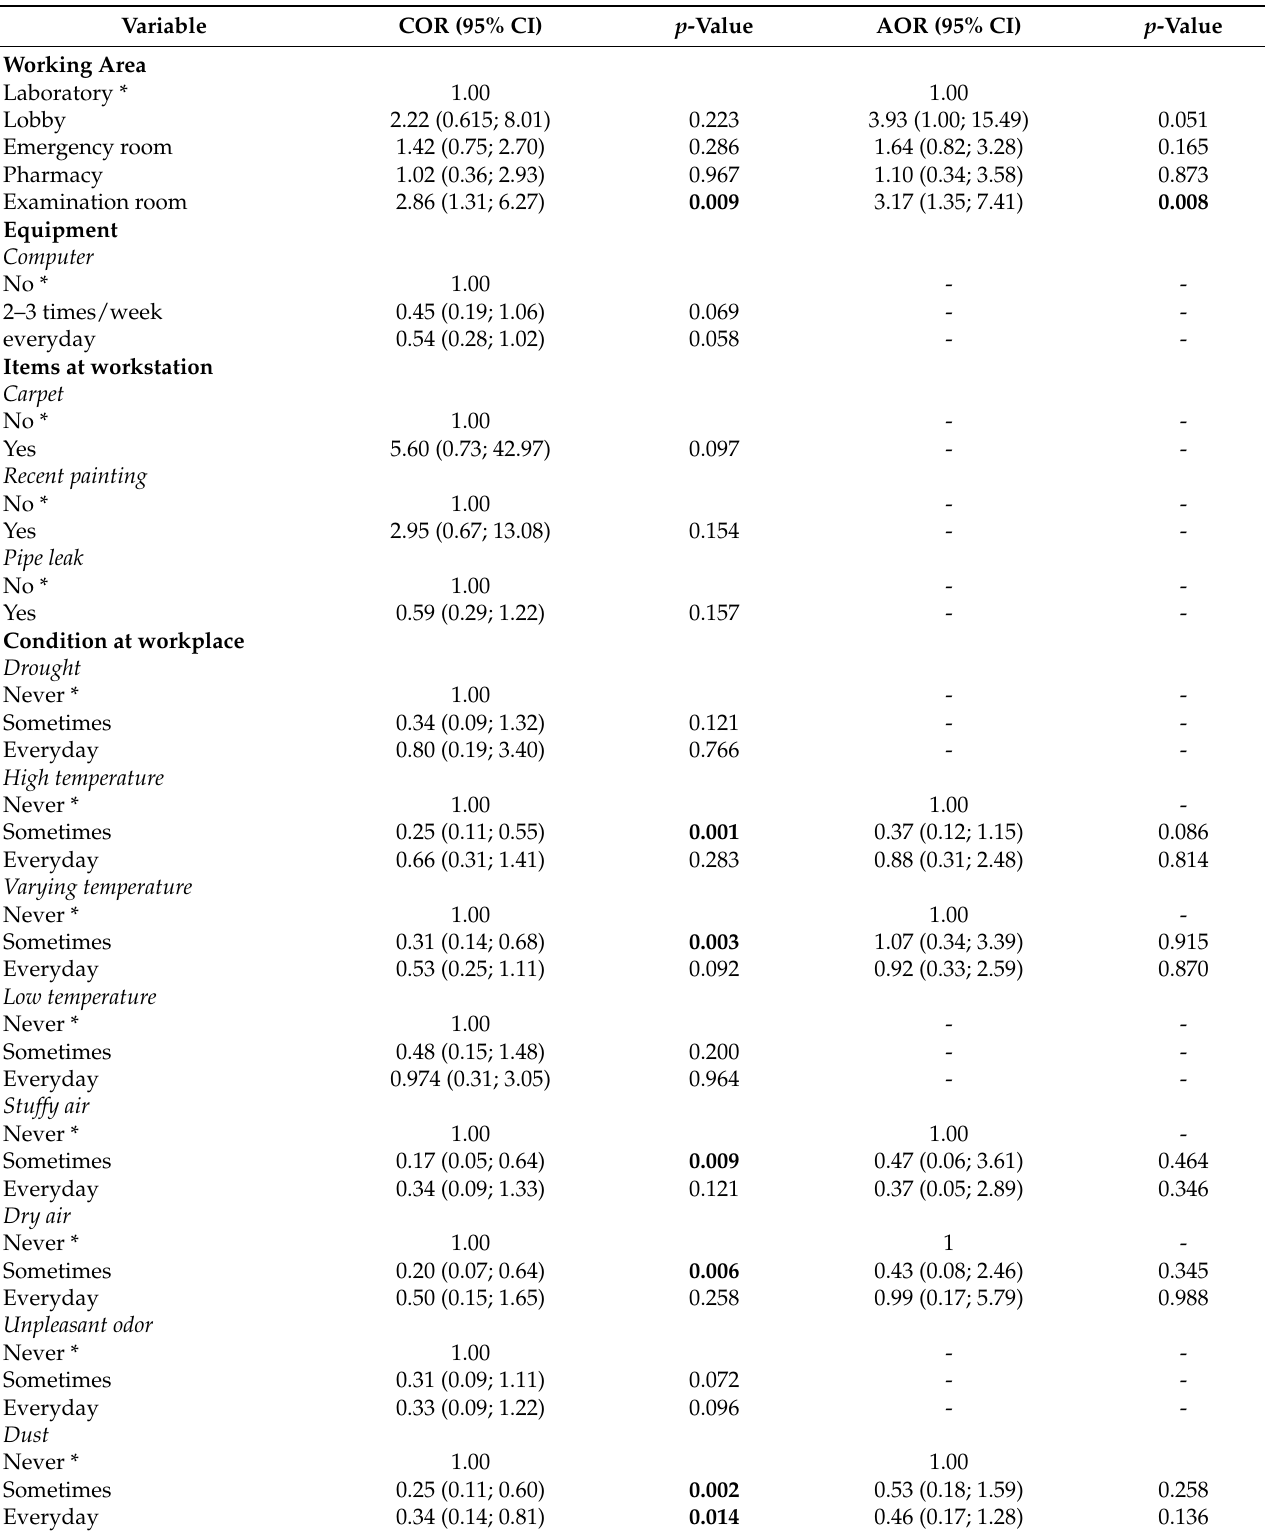
Table 4. Univariate and multivariate regression analysis of SBS among healthcare workers in health